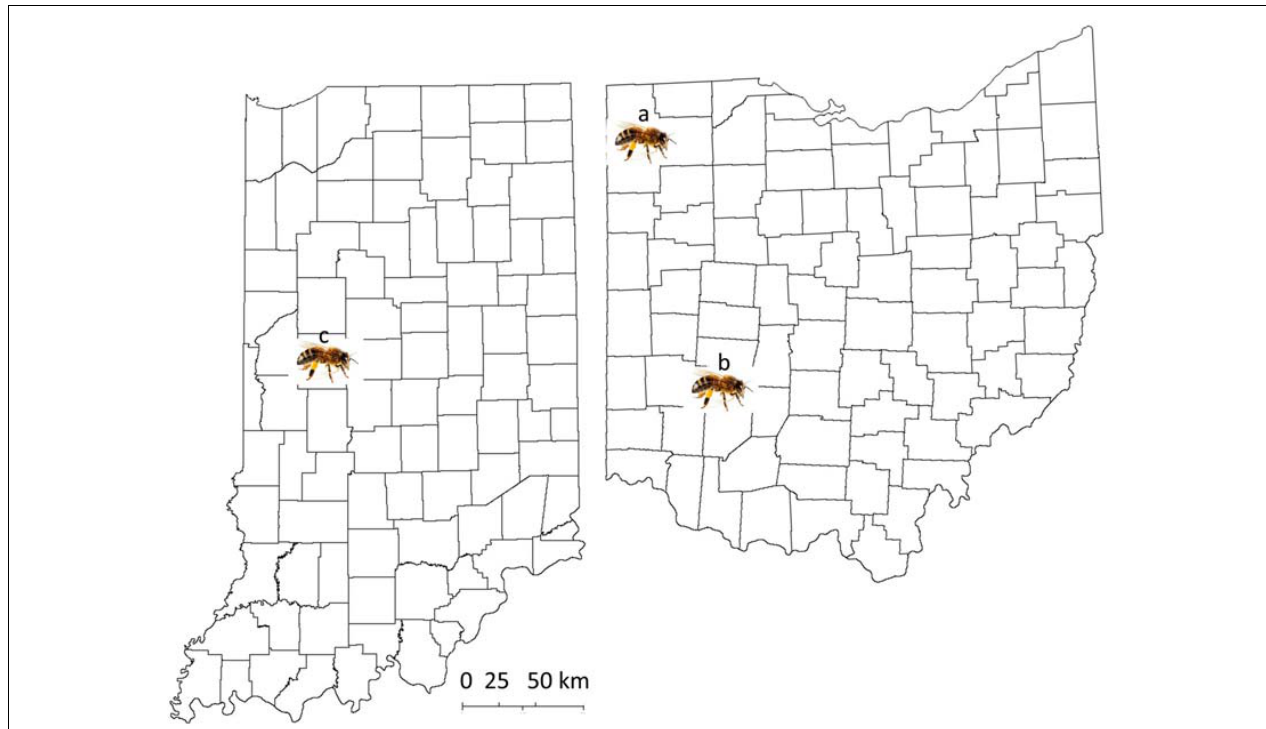
FIGURE 1 | Map of the locations of sample collection from the states of Ohio and Indiana. Site a: Defiance, Ohio; site b: Green County, Ohio, including the cities of Bellbrook, Beavercreek, Cedarville, and Wilberforce; site c: West Lafayette, Indiana, for Indiana mite-biter